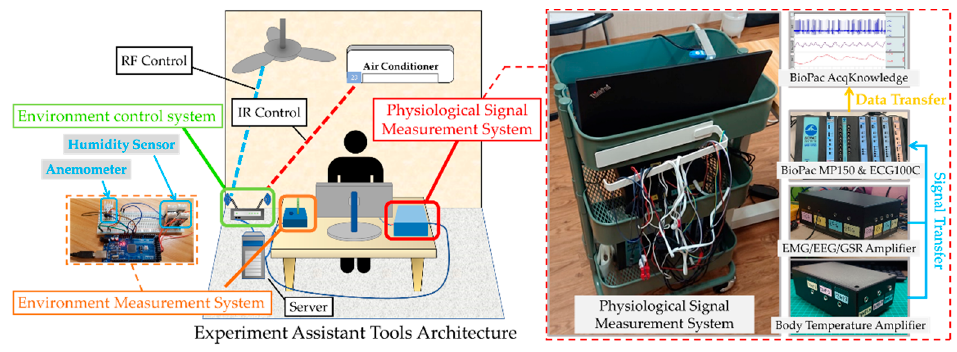
Figure 2. Experiment assistant